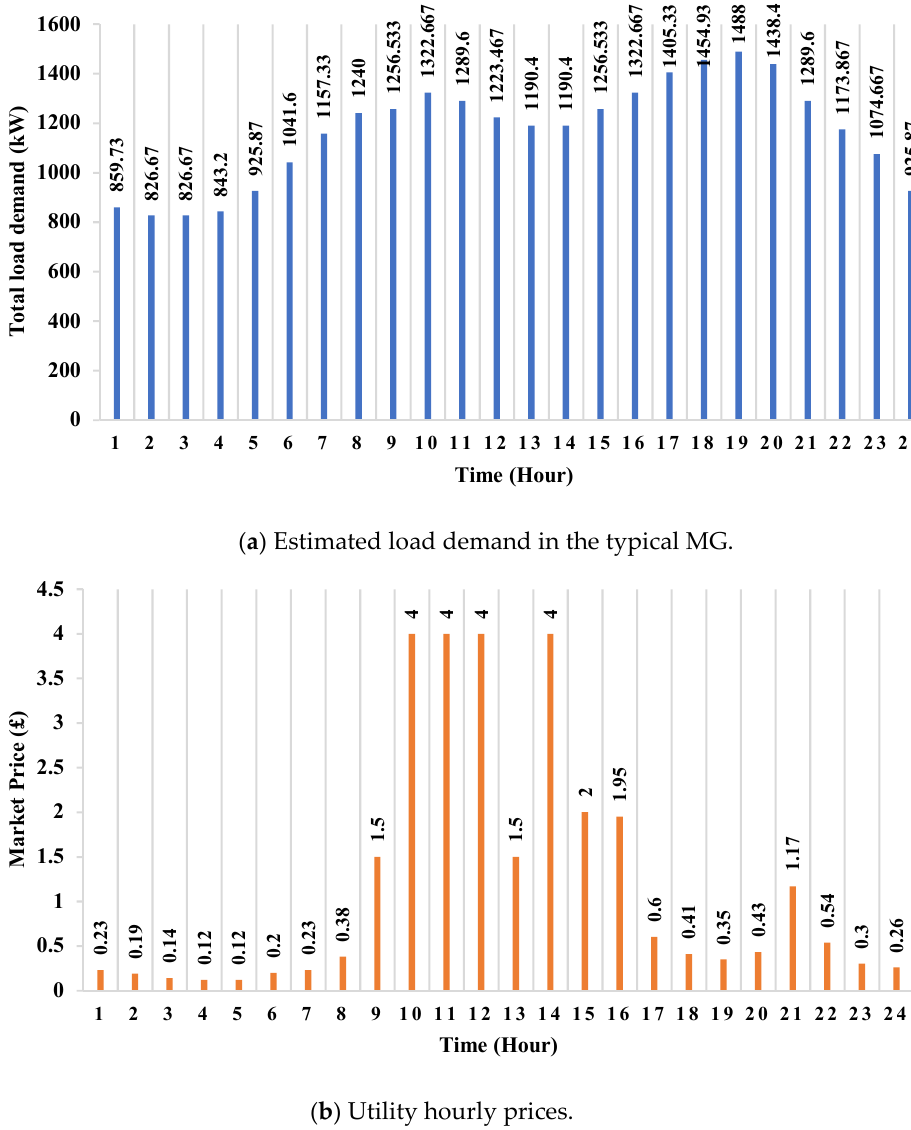
Figure 6. Estimated values of ( a ) load demand and ( b ) utility hourly prices